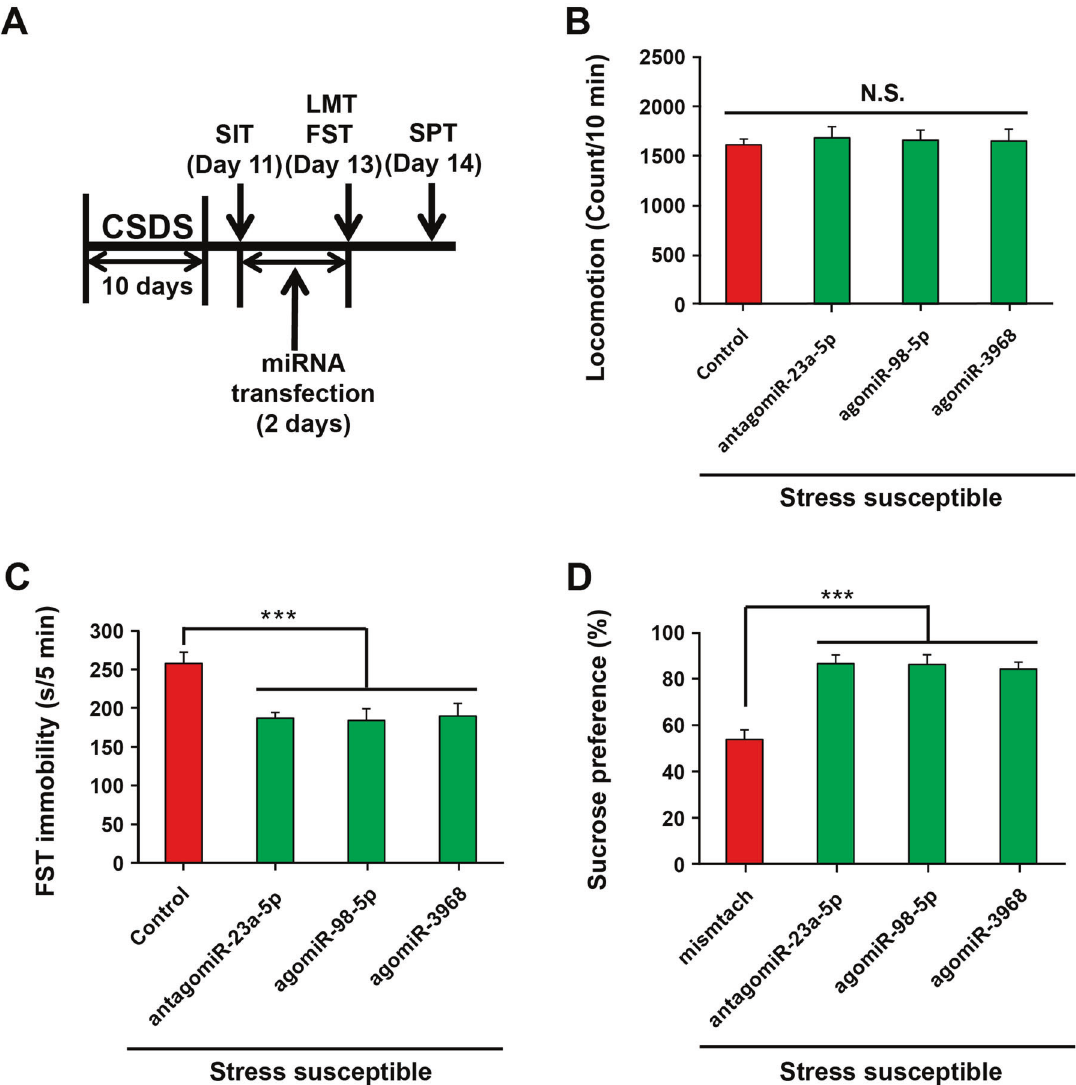
Fig. 3 Effects of miR-23a-5p/-98-5p/-3968 inhibition on depression-like behaviors of CSDS-susceptible mice. a The schedule of miRNA antagonist or agonist administration and behavioral tests after CSDS. b – d The number of squares crossed during LMT, immobility time during FST, and sucrose-preference ratio during SPT. LMT, FST, and SPT were performed to analyze the depression-like behaviors of CSDS-susceptible mice after administration with antagonist to miR-23a-5p or agonist to miR-98-5p or miR-3968. Data are shown as mean ± SEM ( n = 8). *** P < 0.001, N.S. not signi fi